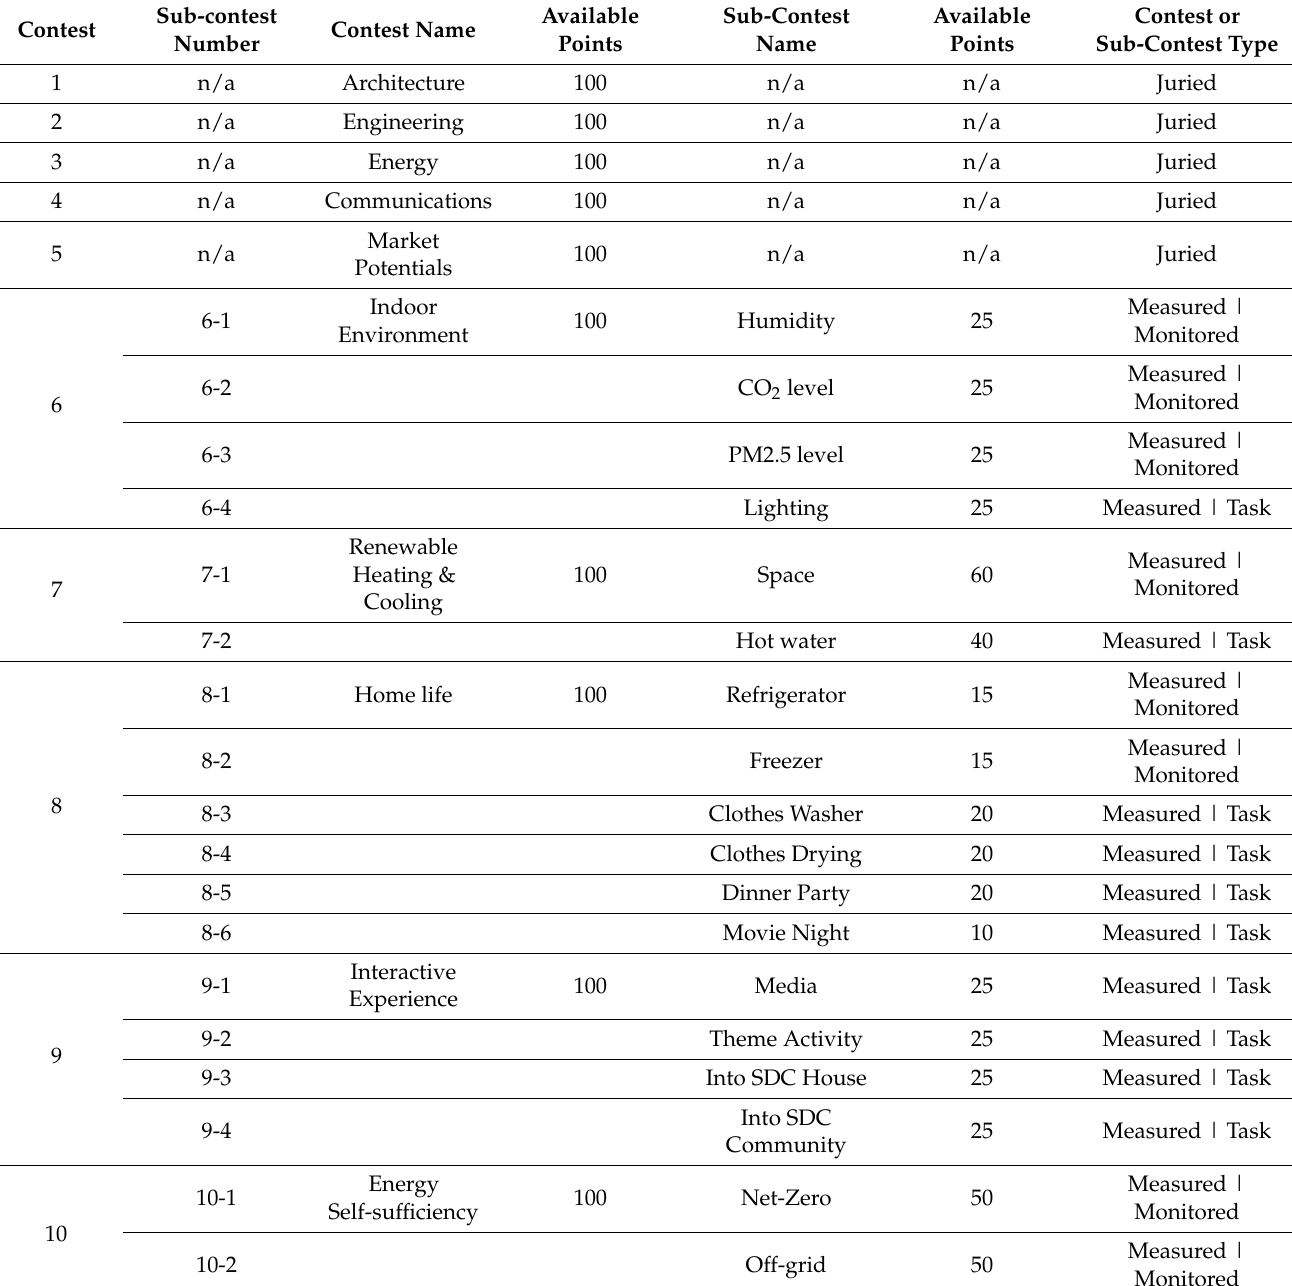
Table 1. Evaluation indices of the third SDC